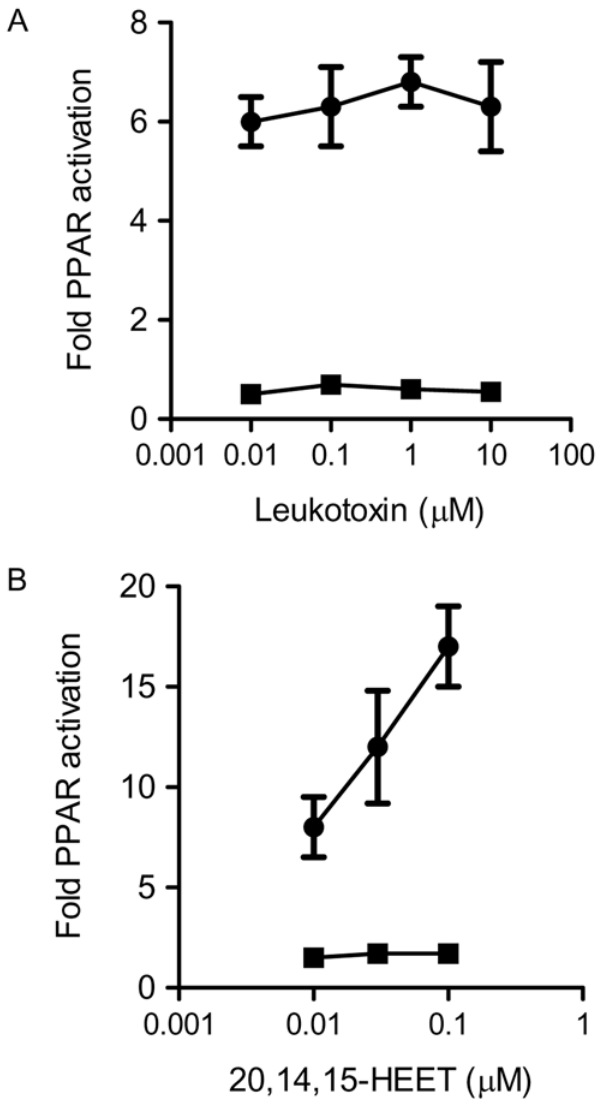
Figure 5. Alternative CYP products and PPAR a activation. (A) PPAR reporter gene activation is not induced by the linoleic acid CYP2J2 metabolite leukotoxin in the presence or absence of PPAR a , but is potently induced by (B) the CYP4A 14,15-EETmetabolite 20,14,15-HEETin the presence of PPAR a . HEK293 cells were transfected with PPAR reporter gene in the presence or absence of PPAR a . 20 h post transfection cells were treated with CYP2J2 products (0–10 m M), for a further 20 h.